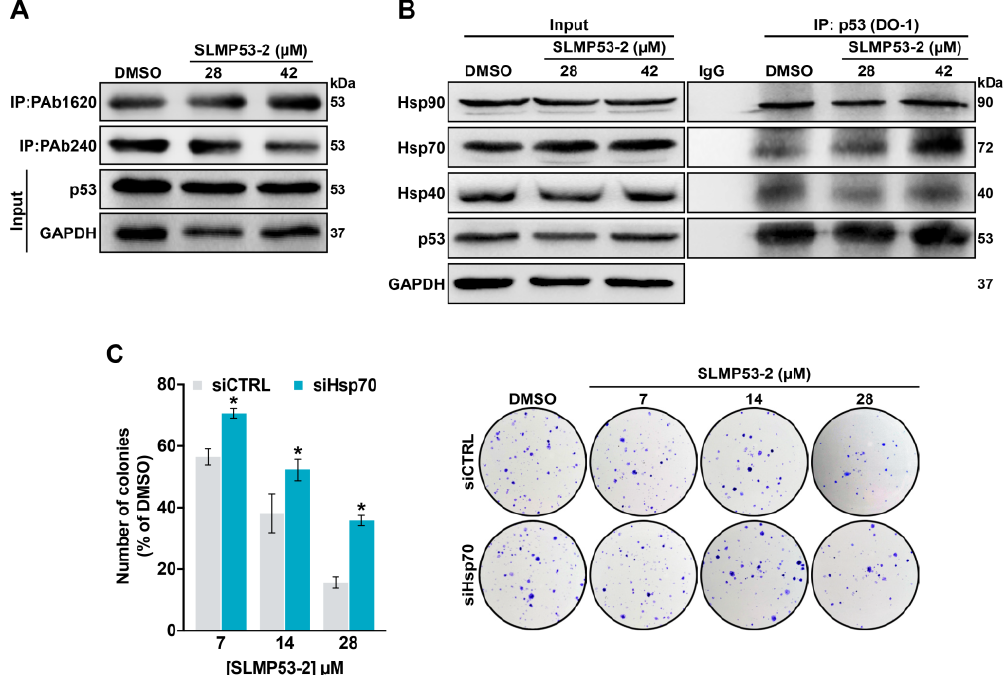
Figure 5. SLMP53-2 restores wt-like folding and promotes mutp53-Y220C interaction with Hsp70. ( A ) Immunoprecipitation of p53 in HuH-7 cells treated with 28 and 42 µM SLMP53-2 for 36 h, using the conformation-specific antibodies PAb240 (mut/unfolded) and PAb1620 (wt/folded), followed by immunoblotting with anti-p53 (DO-1) or anti-Hsp70 antibodies; whole cell lysate (input). Of note that labelling with PAb1620 in DMSO-treated cells may be explained by mutp53-Y220C temperature- sensitivity [ 20 ] . ( B ) Co-immunoprecipitation of Hsp40, Hsp70, and Hsp90 with p53 in HuH-7 cells treated with 28 and 42 µM SLMP53-2 or DMSO for 36 h, using anti-p53 antibody (DO-1), followed by immunoblotting with anti-Hsp40, anti-Hsp70, anti-Hsp90, and anti-p53 antibodies; whole cell lysate (input). ( C ) Effect of SLMP53-2 in the cell colony formation of HuH-7 cells transfected with siRNA